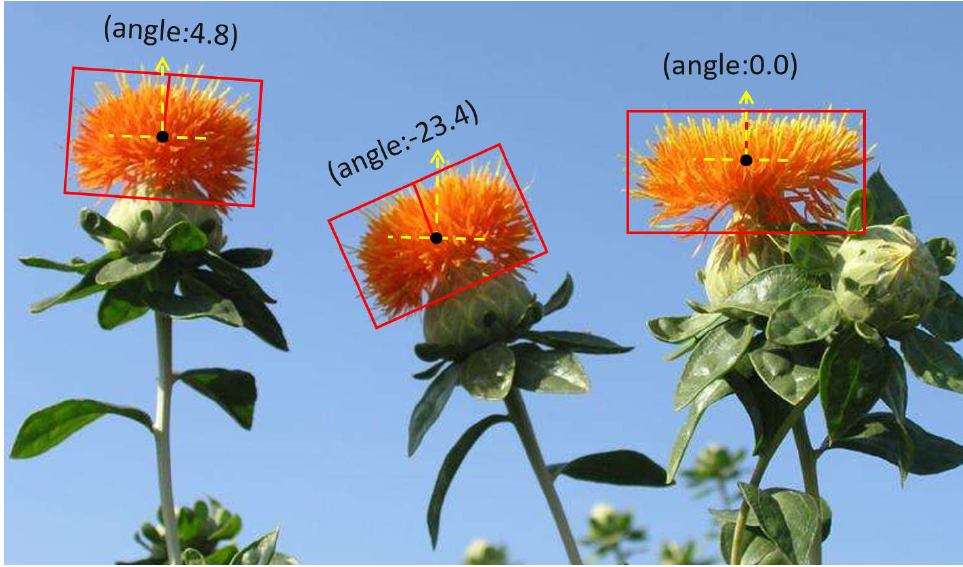
Figure 4. The tilting angle information of safflower.